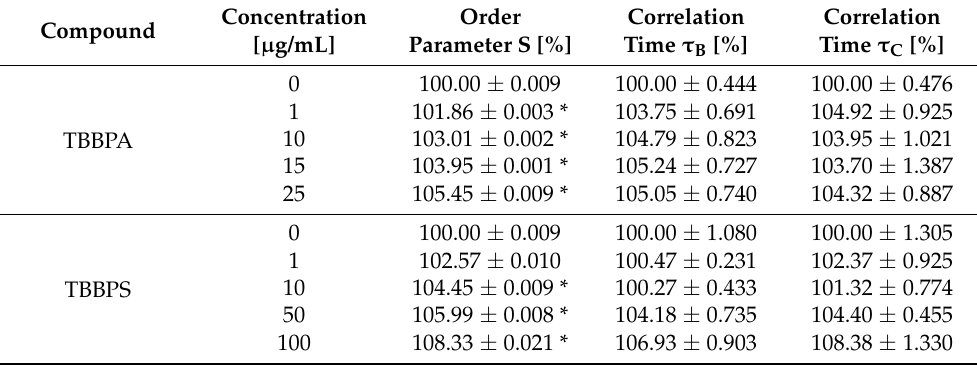
Table 1. Changes in parameter S and correlation times of τ B and τ C in human control erythrocytes and the erythrocytes incubated with TBBPA at 1 to 25 µ g/mL and TBBPS at 1 to 100 µ g/mL for 48 h. (*) Significantly different from control ( p < 0.05).